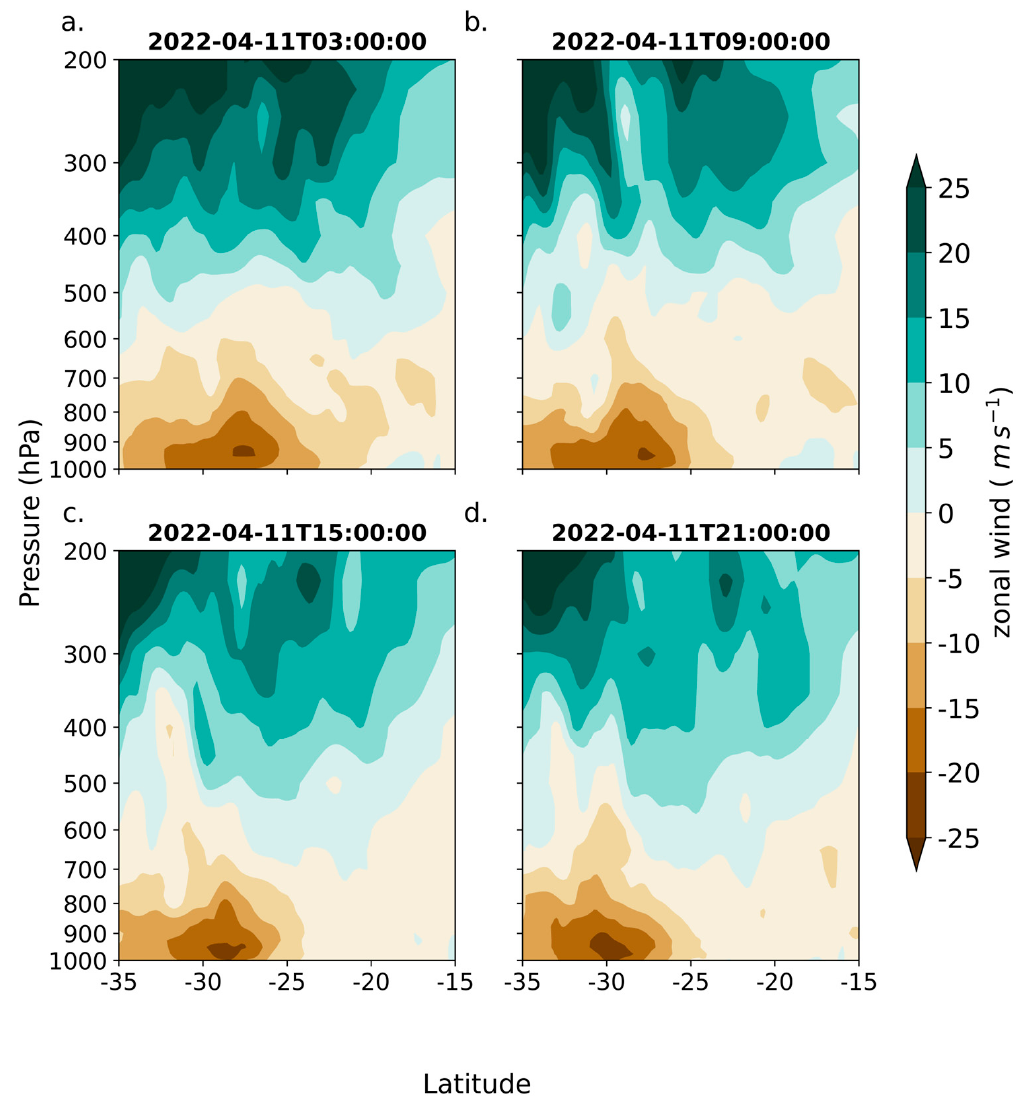
Figure 8. Latitude-height cross sections of the ERA5 zonal wind (shaded; m s − 1 ) along 36 ◦ E at ( a ) 0300 UTC, ( b ) 0900 UTC, ( c ) 1500 UTC and ( d ) 2100 UTC on 11 April 2022.